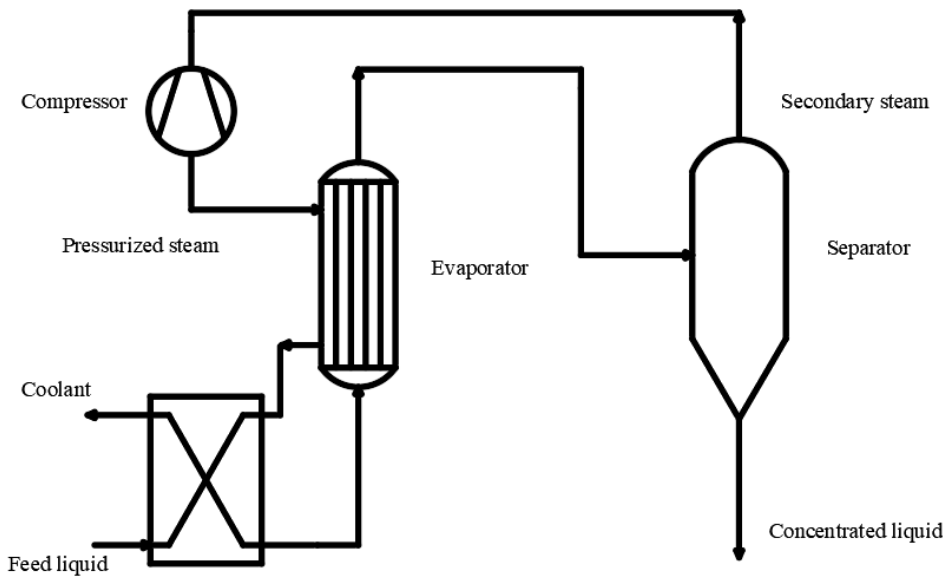
Figure 3. Mechanical vapor recompression process.